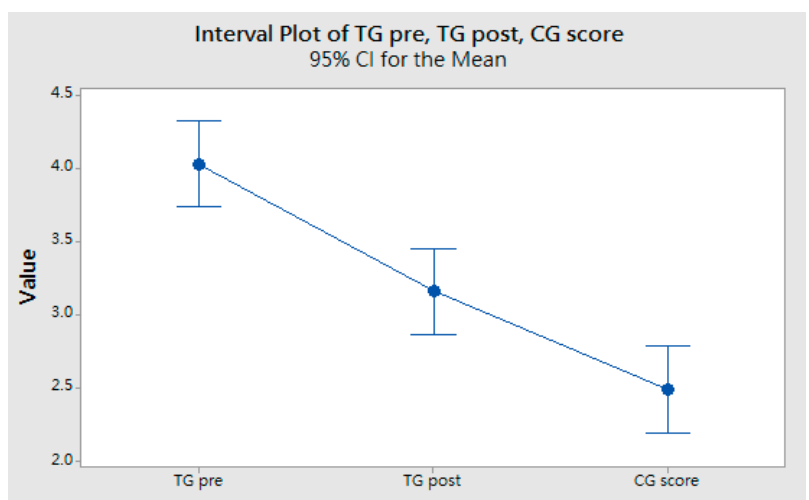
Figure 7. One-way ANOVA interval plot of TG pre, TG post, and CG score.